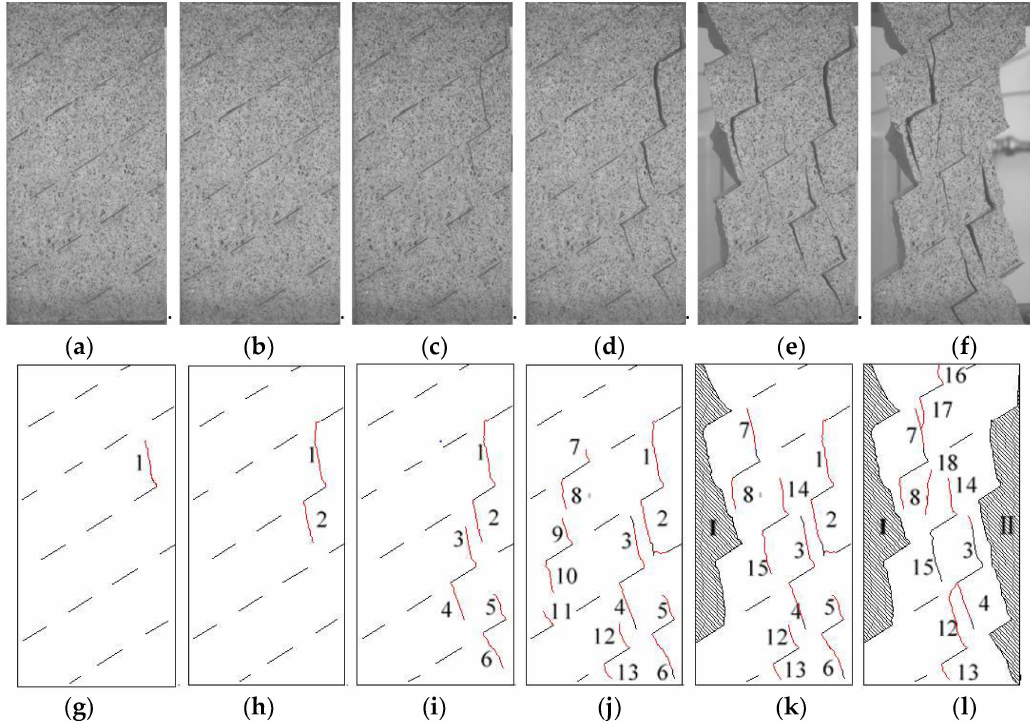
Figure 7. Fracture evolution of intermittent jointed rock masses under uniaxial compression (Specimen U03, α = 30 ◦ ). ( a ) 0.250, 5.97; (b) 0.252, 6.04; ( c ) 0.265, 6.36; ( d ) 0.300, 6.31; ( e ) 0.369, 7.14; ( f ) 0.506, 5.03; ( g ) 0.250, 5.97; ( h ) 0.252, 6.04; ( i ) 0.265, 6.36; ( j ) 0.300, 6.31; ( k ) 0.369, 7.14; ( l ) 0.506,